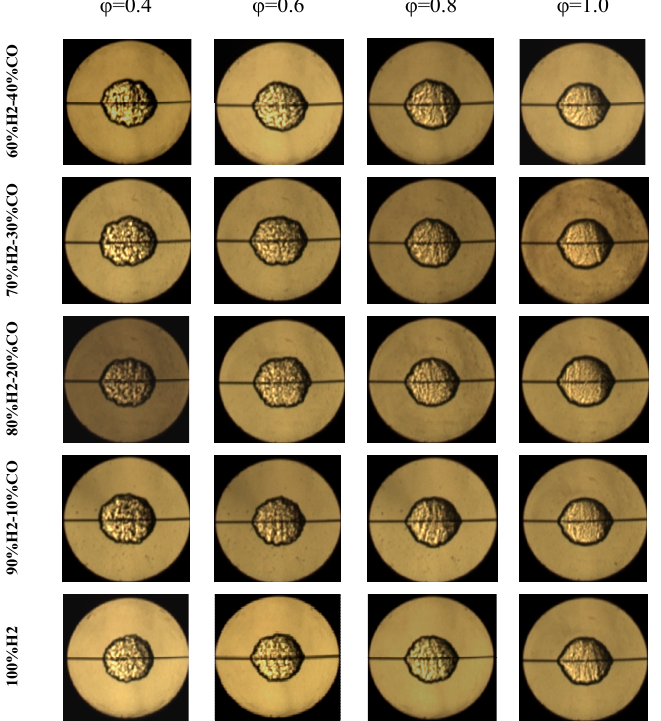
Figure 5. Schlieren pictures for flames with hydrogen fractions from 60% to 100% at 0.3 MPa at different equivalence ratios for 20 mm